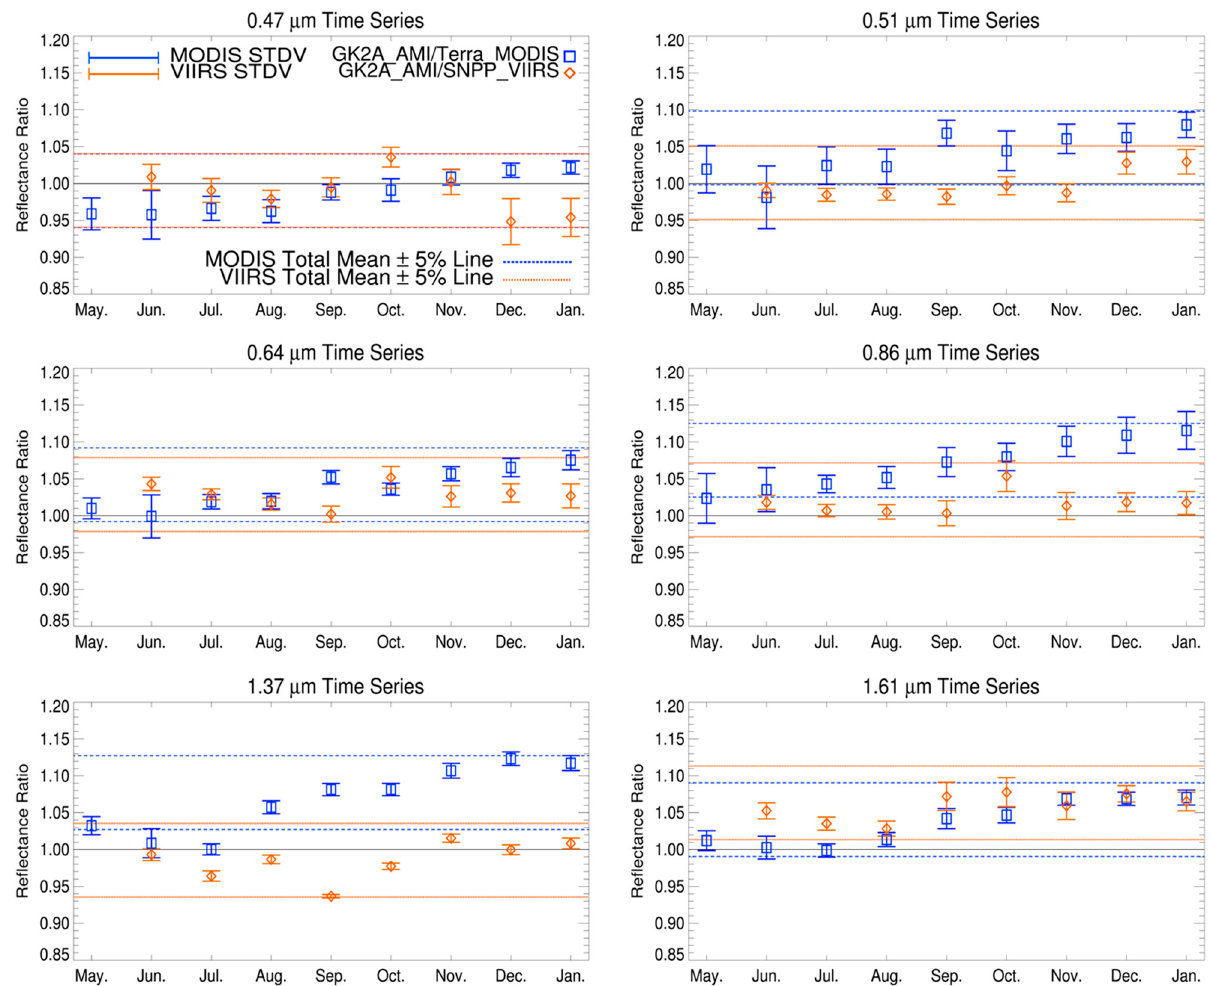
Figure 6. Ray-matching results from May 2019 to January 2020. Trend of the ratio of observation to reference computed using the ray-matching approach. The blue square (MODIS) and orange diamond (VIIRS) represent monthly averages of reflectance ratio (AMI/low earth orbit (LEO)). The error bar is standard deviation of monthly reflectance ratio. Each dotted line represents the upper/lower 5% line from the total mean values of the reflectance ratio.